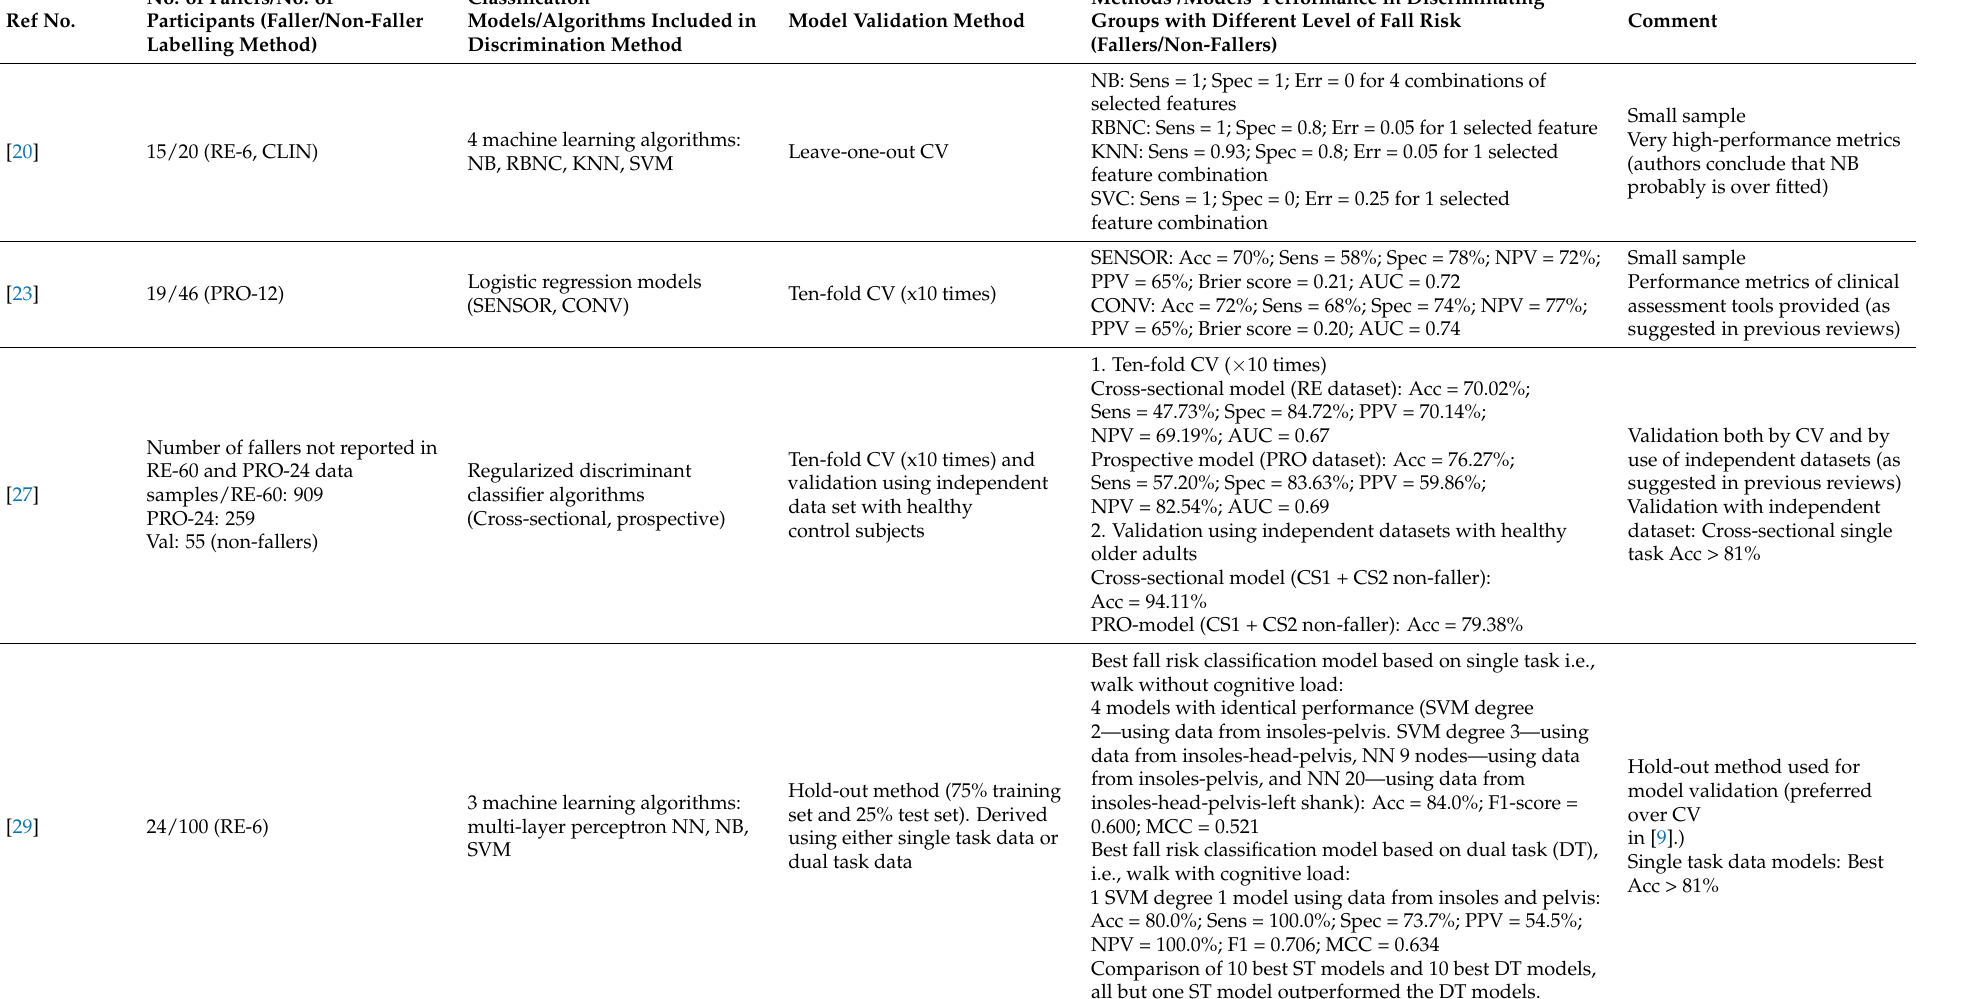
Table 10. Statistical analyses on the sensor-based classification models’ performance in classifying older individuals according to their risk of falling. NPV = Negative Predictive Value, PPV = Positive Predictive